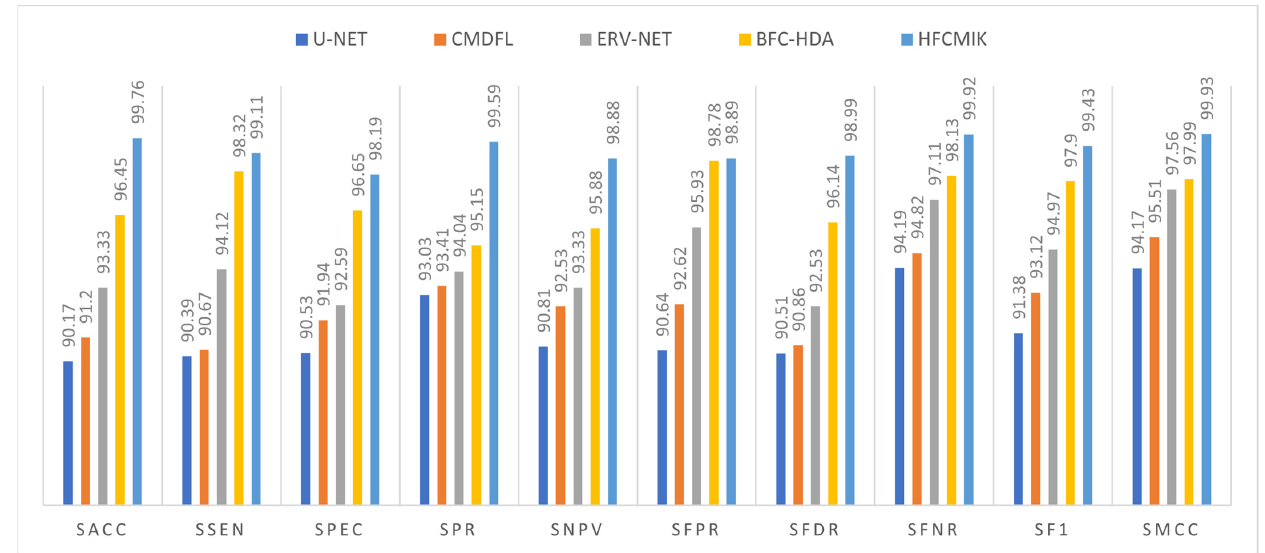
Figure 11. Graphical representation of segmentation performance comparison in percentage (U- NET [20], CMDFL [22], ERV-NET [23], BFC-HDA [27]).